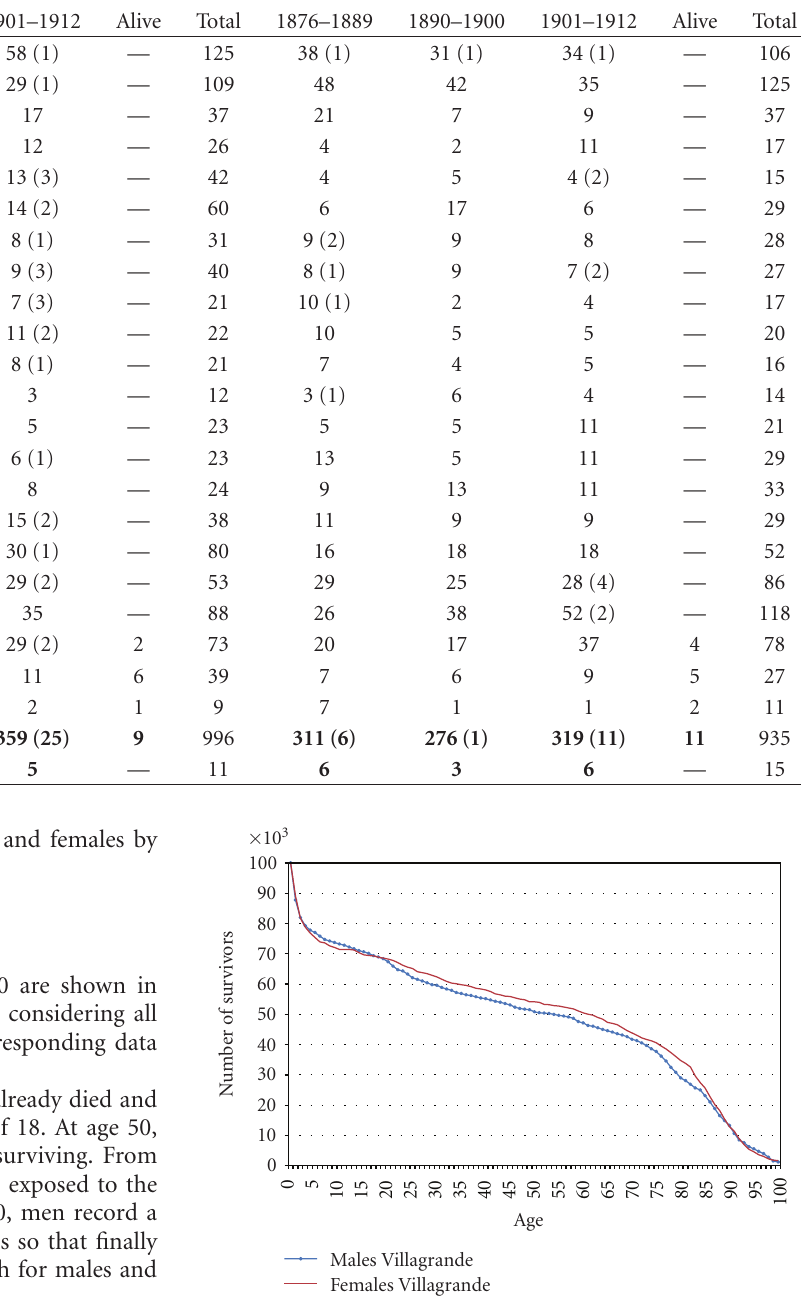
Figure 1: Comparing survival curves for males and females in Villagrande for a hypothetical cohort of 100,000 newborns of the years